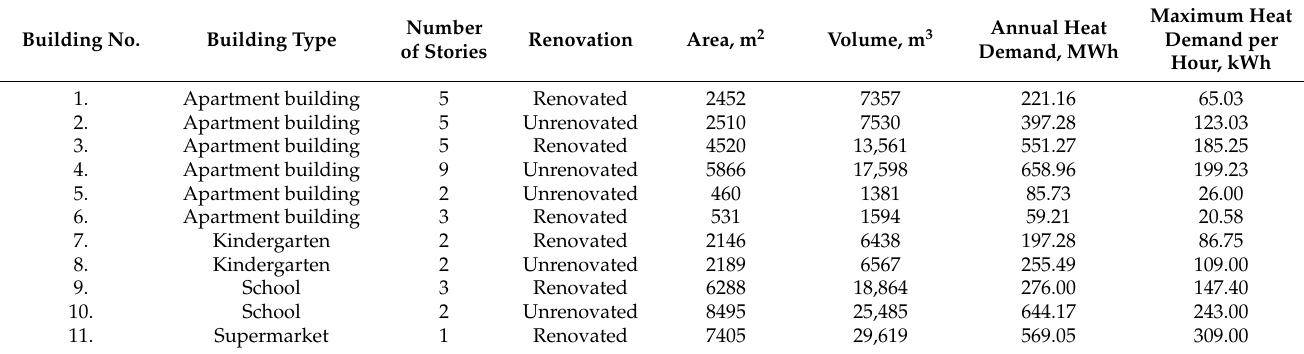
Table 1. The main information of the analyzed buildings.